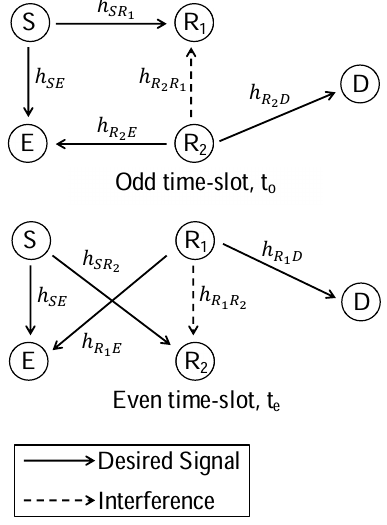
Figure 1. The secrecy two-path successive relaying (TPSR) network with an